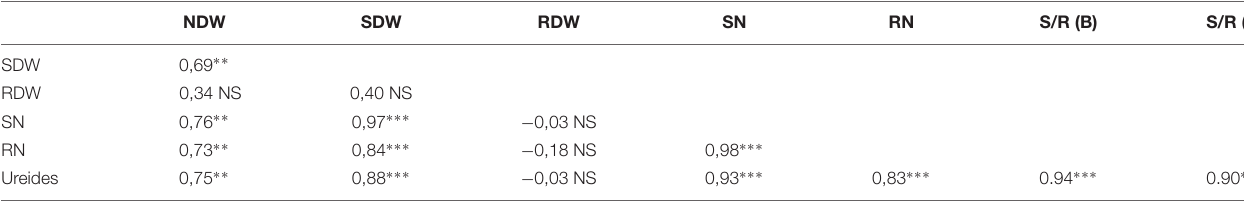
TABLE 4 | Correlation coefficients ( r ) for pairs of symbiotic parameters. NDW SDW RDW SN RN S/R (B)